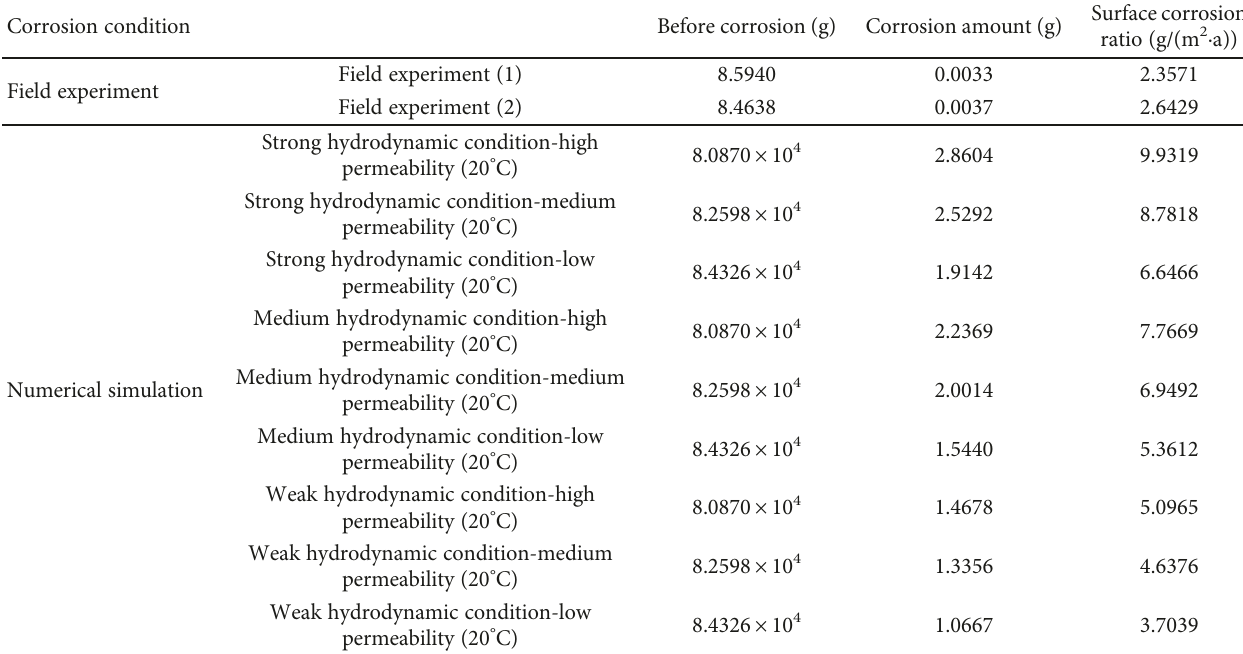
Table 5: The surface corrosion ratios of the fi eld experiment and numerical simulation. Corrosion condition Before corrosion